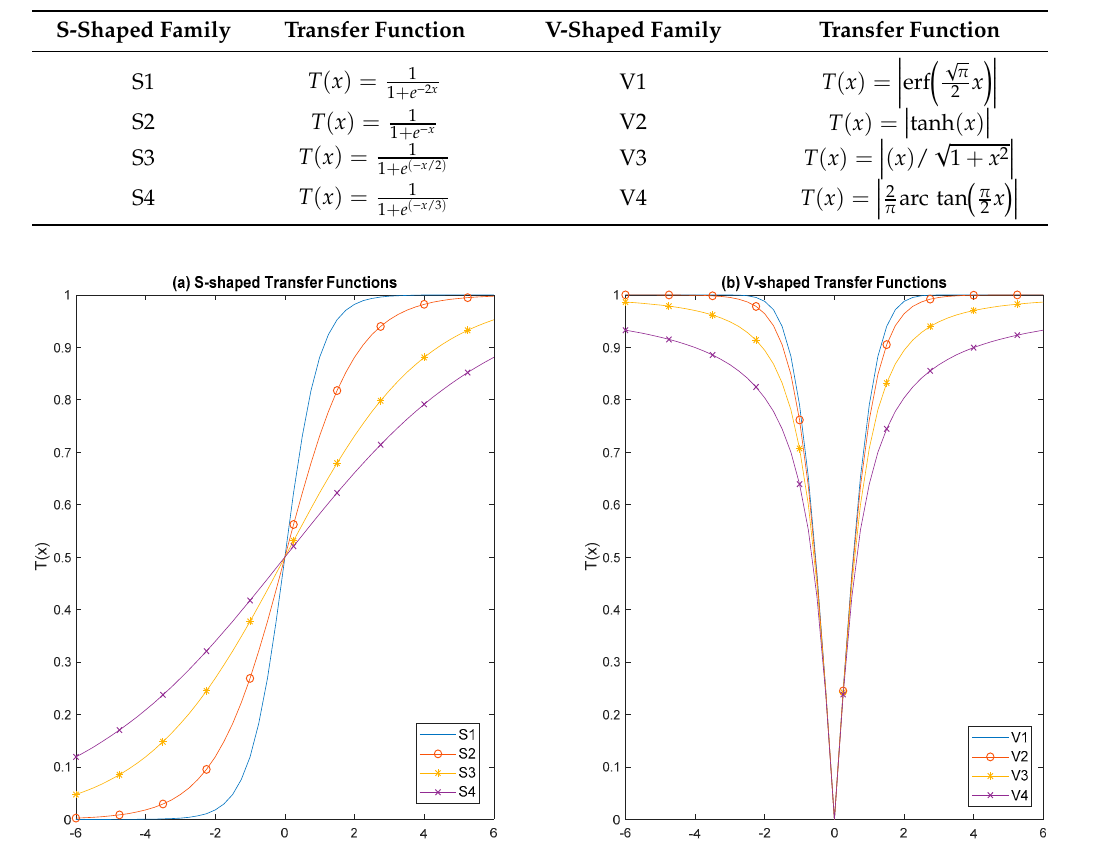
Figure 2. Sample S-shaped and V-shaped transfer functions. ( a ) S-shaped transfer fFunctions and ( b ) V-shaped transfer functions.